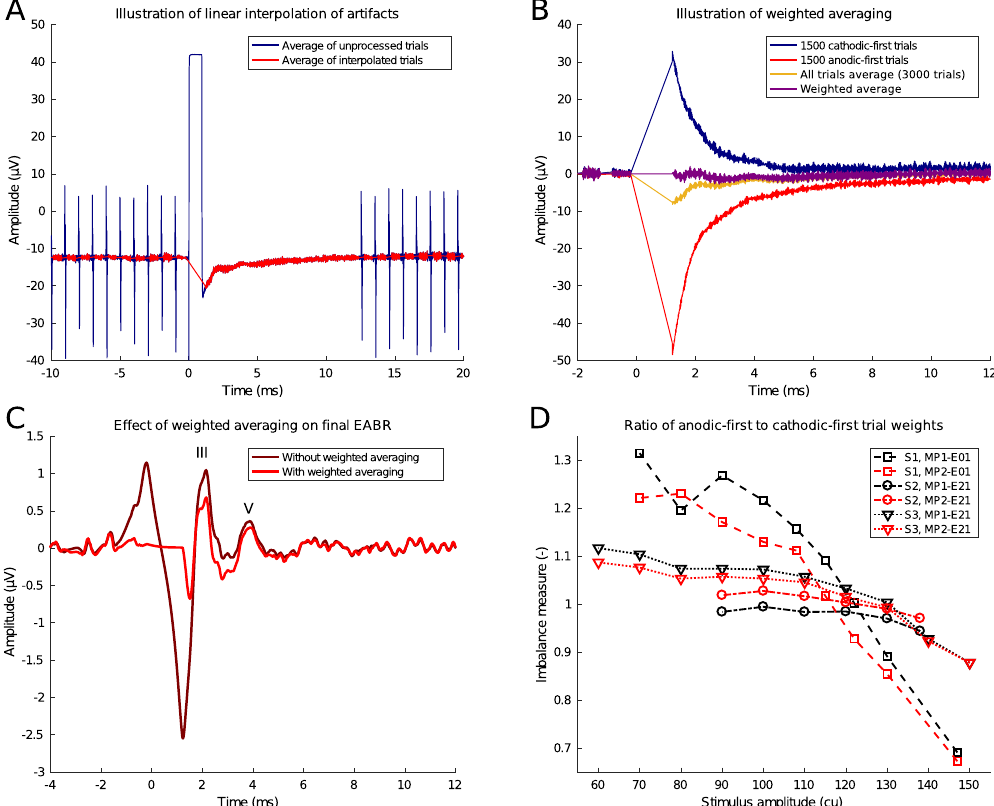
Figure 8. Illustration of signal processing techniques. This is an example from an EABR at C-level from subject S1, recorded between electrodes MP2-E01 using bipolar stimulation between electrodes E21-E13. ( A ) Example of pedestal artifact caused by amplifier blanking, and power-up frame artifacts before and 12 ms post-stimulus. These artifacts are removed by linear interpolation. ( B ) Example of weighted averaging procedure to remove sawtooth artifact introduced by linear interpolation. ( C ) Final EABR trace after signal processing with and without weighted averaging. Waves III and V are marked. ( D ) Imbalance between amplitudes of